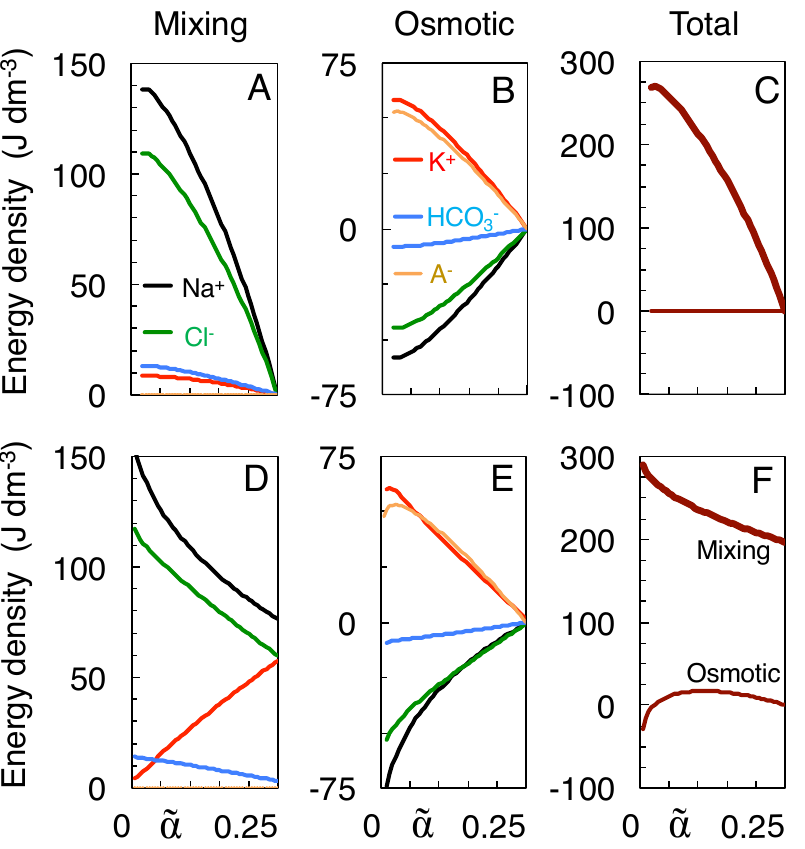
Figure 4. Work done by mixing ( A , D ), osmotic work done ( B , E ), and total work done ( C , F ). Work, expressed as energy density in joule per liter, is compared for neuronal swelling along the isotonic path ( A – C ) and swelling to the Donnan equilibria at the same volumes ( D – F ), each time start- ing from ˜ α = 0.25. ( A , D ) Work calculated from Equation (12). ( B , E ) Work calculated by adding Equations (13a) and (13b). ( C , F ) Total work of mixing (thick line) and total osmotic work (thin), obtained by adding over all ion